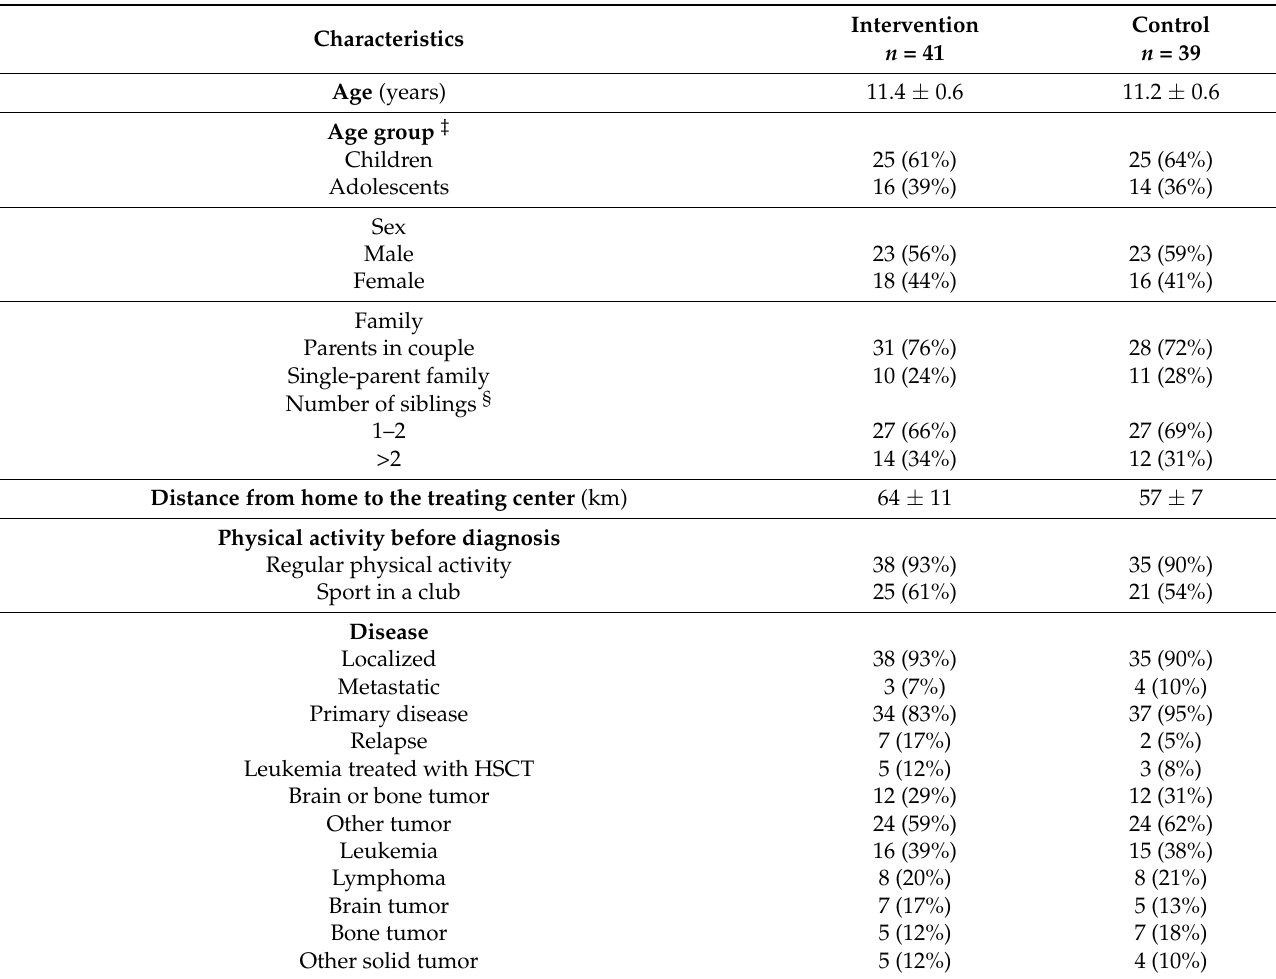
Figure 1. Eligibility, randomization, and follow-up. PAP: physical activity program. Table 1. Baseline characteristics according to trial group.